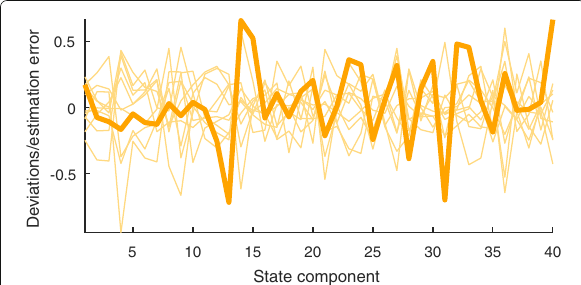
Fig. 19 The estimation error x k − ¯ x k | k for k = 10 4 with the deviation ensemble (cid:7) X k | k in the background for an EnKF with N = 10, covariance localization, and inflation factor c =